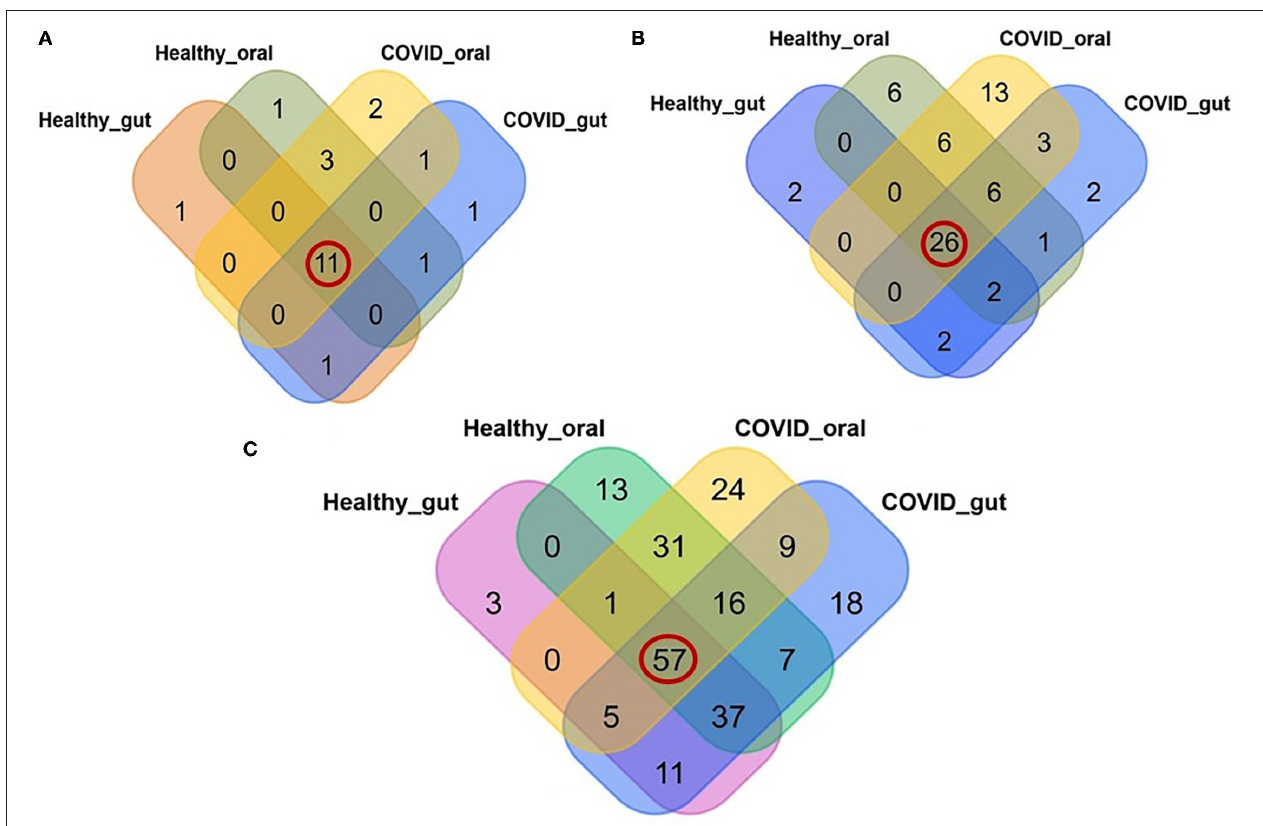
FIGURE 3 | Relative abundance of bacteria at phylum, order and genus level in the gut and oral wash of healthy controls and COVID-19 cases. (A) Bacterial abundance at the phylum level. Of 22 detected phyla, 11 (50.0%; highlighted in red circle) were shared across all the sample categories. (B) Bacterial abundance at the order level. A total of 69 orders of bacteria were detected, of which 26 (37.68%) were found to be shared across all samples. (C) Bacterial abundance at the genus level. A total of 231 bacterial genera were identified in the gut and oral samples of patients with COVID-19 and healthy controls, among which 57 (24.68%) were common to all four groups of